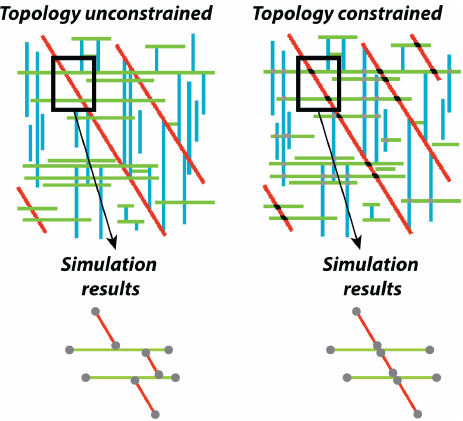
Figure 6. Comparison between results obtained without constrain- ing the topology and those obtained with topological facies con-